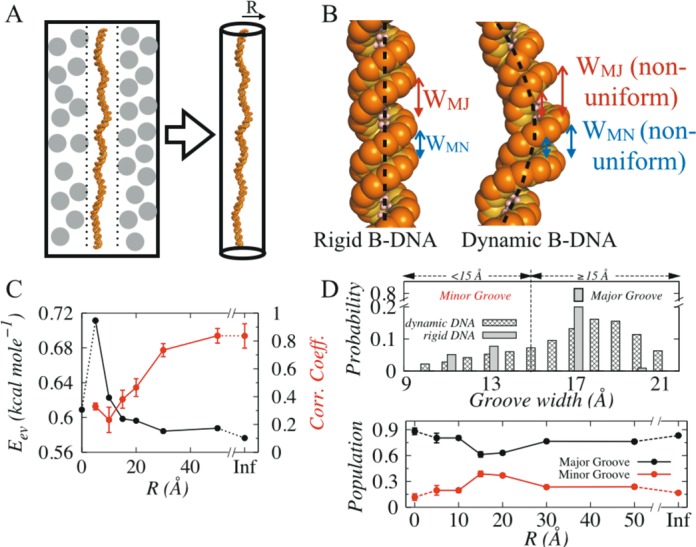
Structural characterization of rigid and dynamic DNA molecules. (A) The impact of cellular crowding on DNA can be effectively captured by a spherical cylinder of radius R associated with a caging potential Vcage. (B) Dynamics induced structural deformation in rigid and dynamic B-DNA molecules (partly shown). Unlike B-DNA geometry, major (WMJ) and minor (WMN) groove widths vary significantly in dynamic DNA coupled with commonly observed bent DNA axis. (C) Variation of steric clashes (Eev, denoted black line) and correlation in dynamics of interacting molecules (red line) as function of intracellular space R at 20 mM. Depending on the degree of DNA confinement (indicated by R), these two parameters jointly determine the inter-communication between protein and DNA molecules. (D) Correlations between the occupancy probability of major (black) and minor (red) grooves with the degree of DNA confinement.